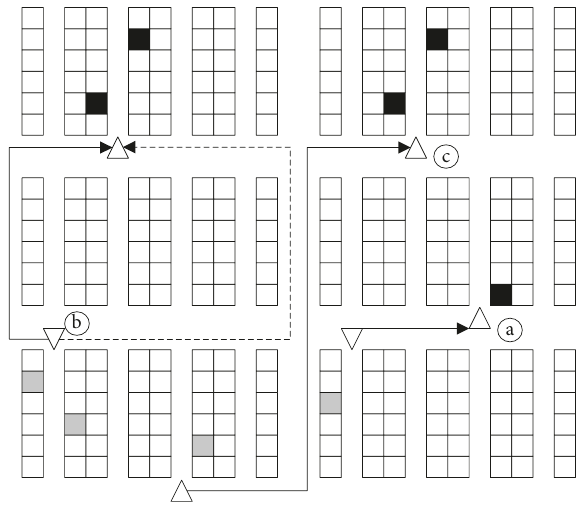
Figure 5: The definition rules of the moving